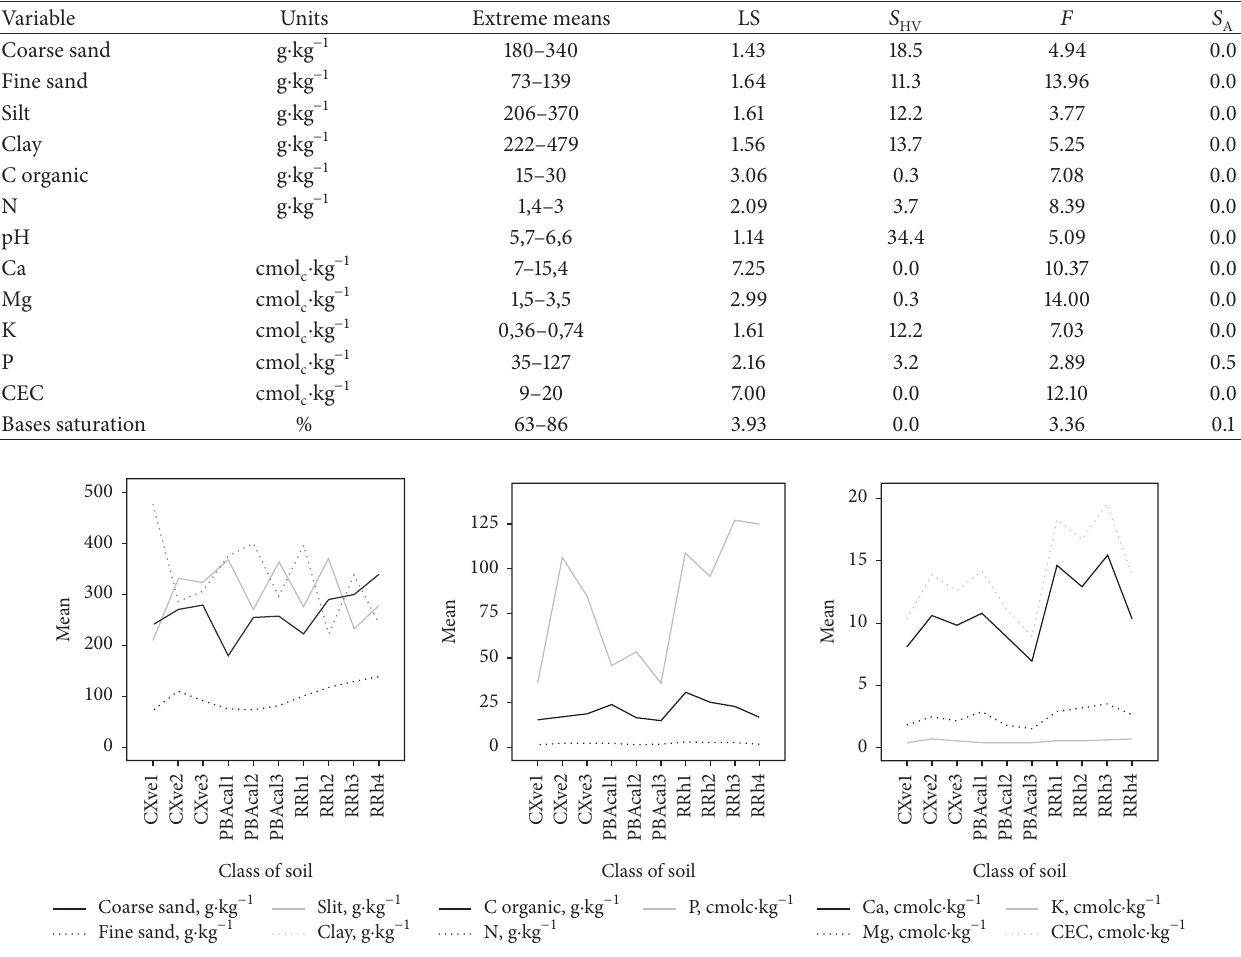
Figure 2: The linear graphs show the variation of the mean related to each class of soil for different